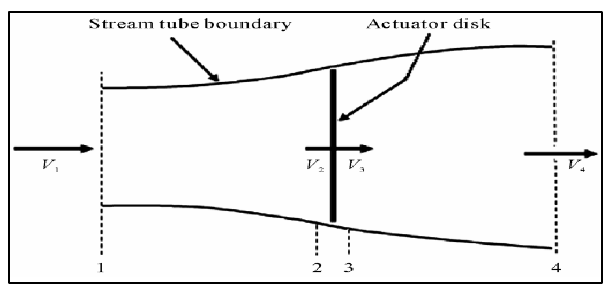
Figure 1. Actuator disk model [16]